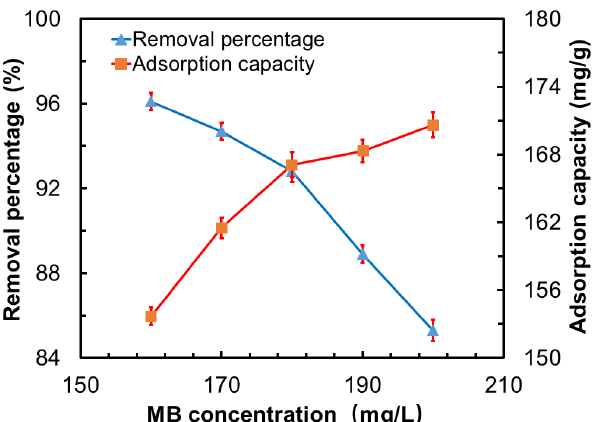
Figure 9. Influence of the MB concentration on the removal percentage and adsorption capacity of the GO ‐ CNT/AC composites [Conditions: adsorbent amount = 100 mg, MB solution amount = 100 mL, pH = 7, adsorption time = 300 min, CNT concentration = 3 mg/mL, MB solution concentrations were 160, 170, 180, 190, and 200 mg/L, respectively].